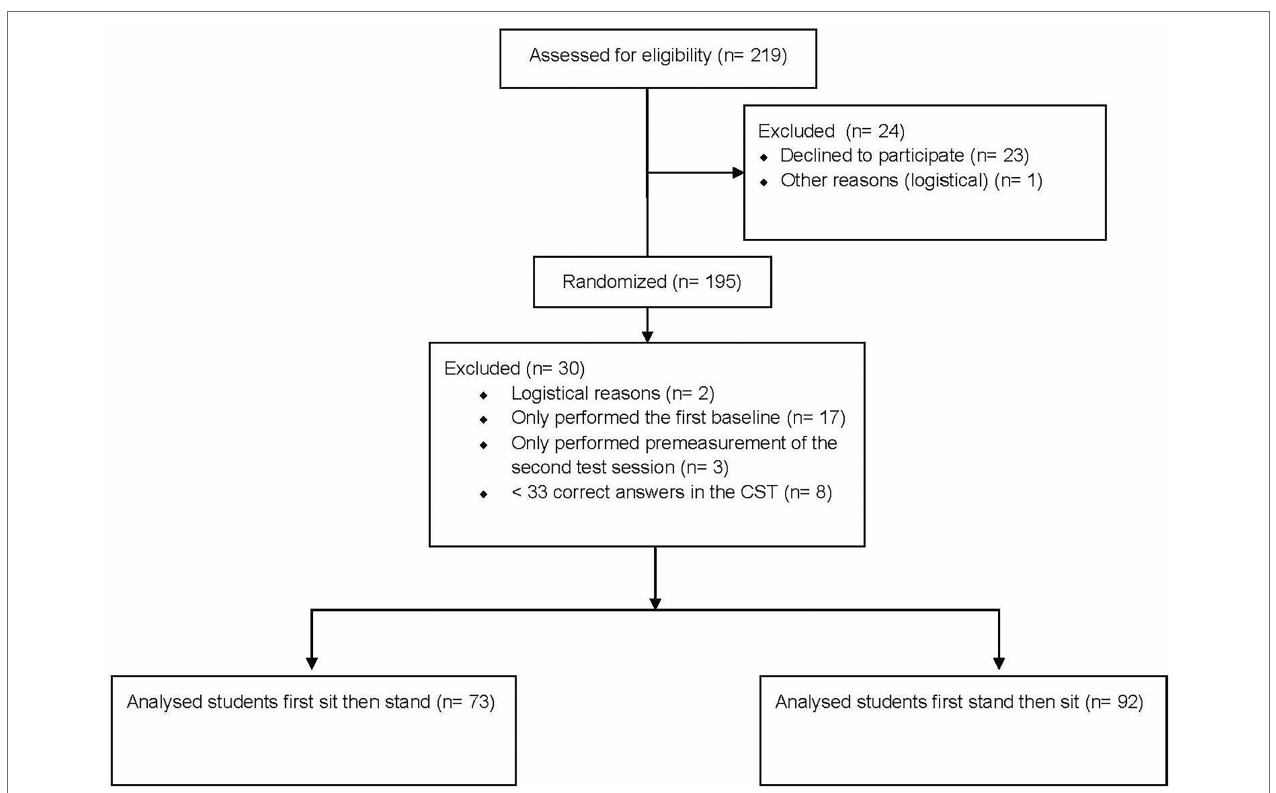
FIGURE 2 | Flow diagram: progress of participants through the